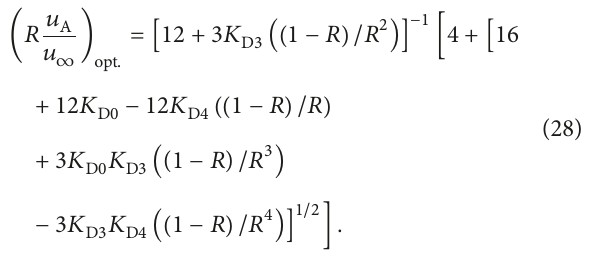
Figure 11: The ratio of maximum power density (1/𝑅)𝐶 reference value (1/𝑅)𝐶 ratio. The abscissa represents 𝑅 from values 0 to 1 and 1/𝑅 from 1 onwards.Thecurvesaredrawnforvariousvaluesof 𝐾 0.25 .